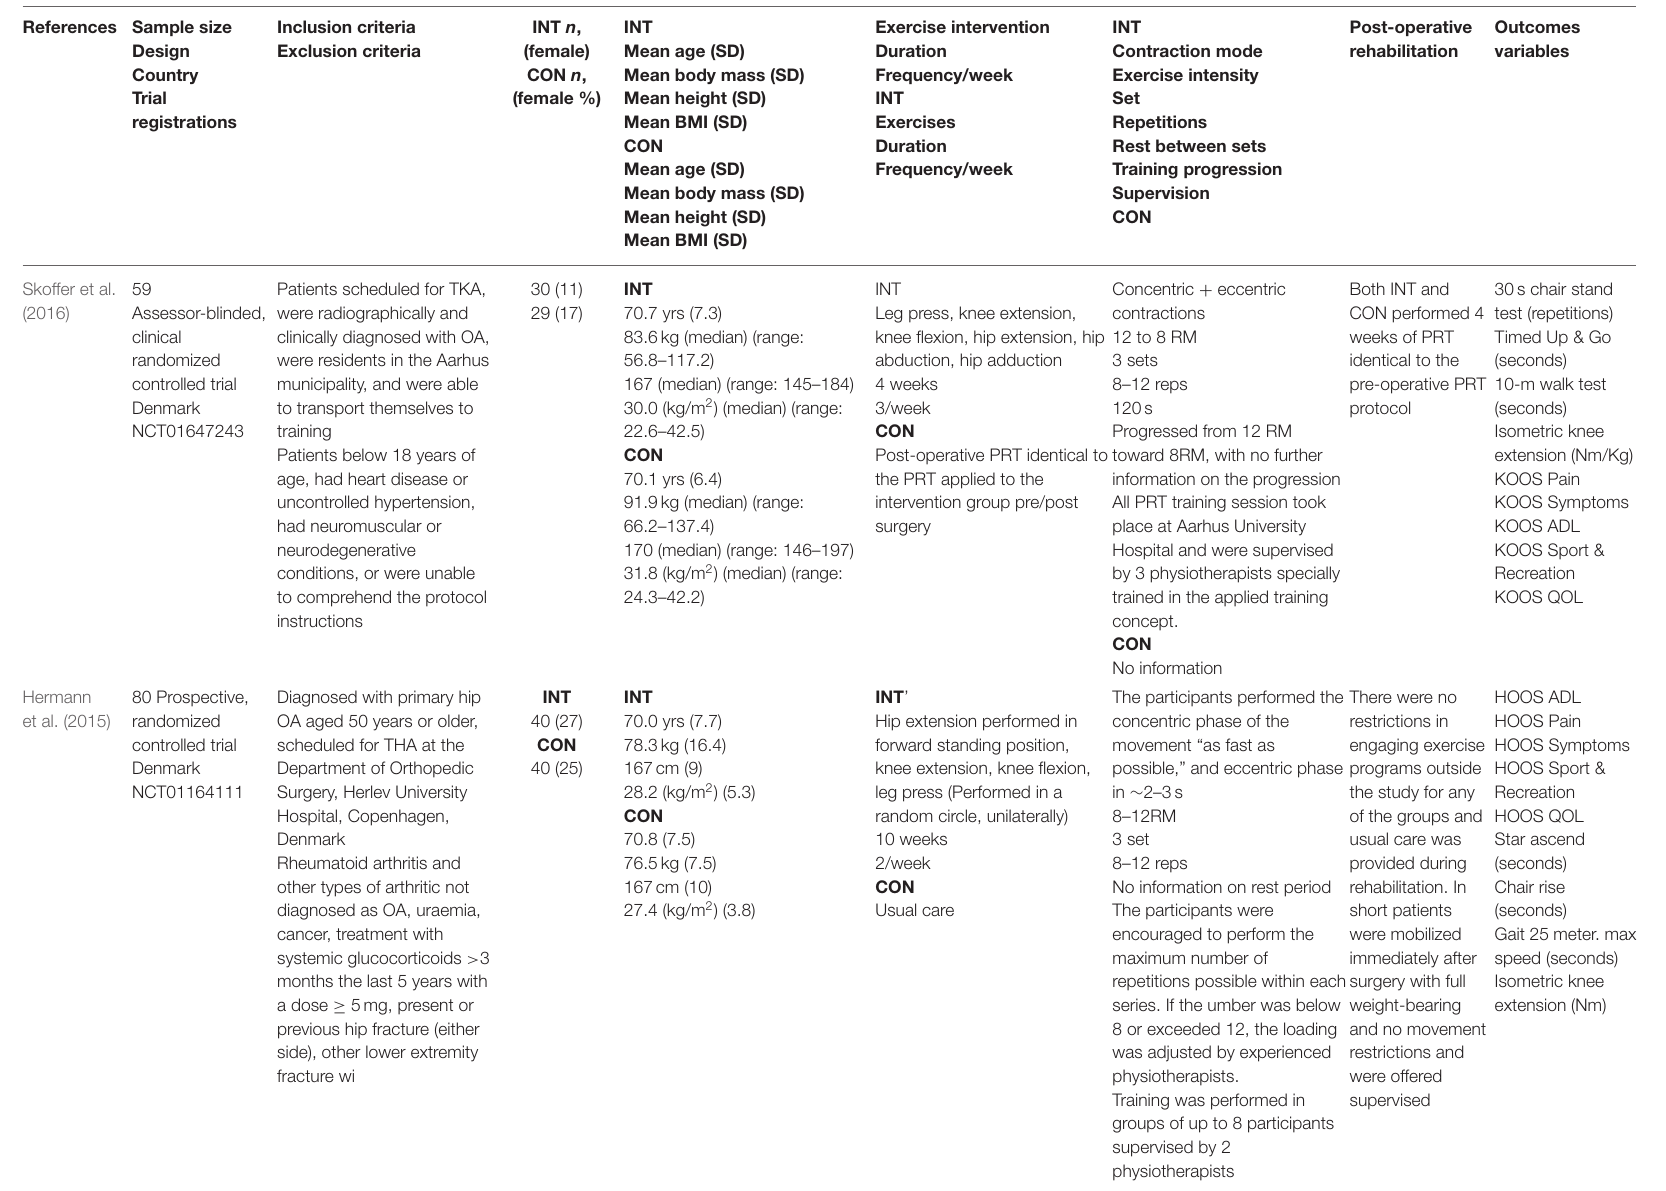
TABLE 1 | Trial characteristics of the five included randomized controlled